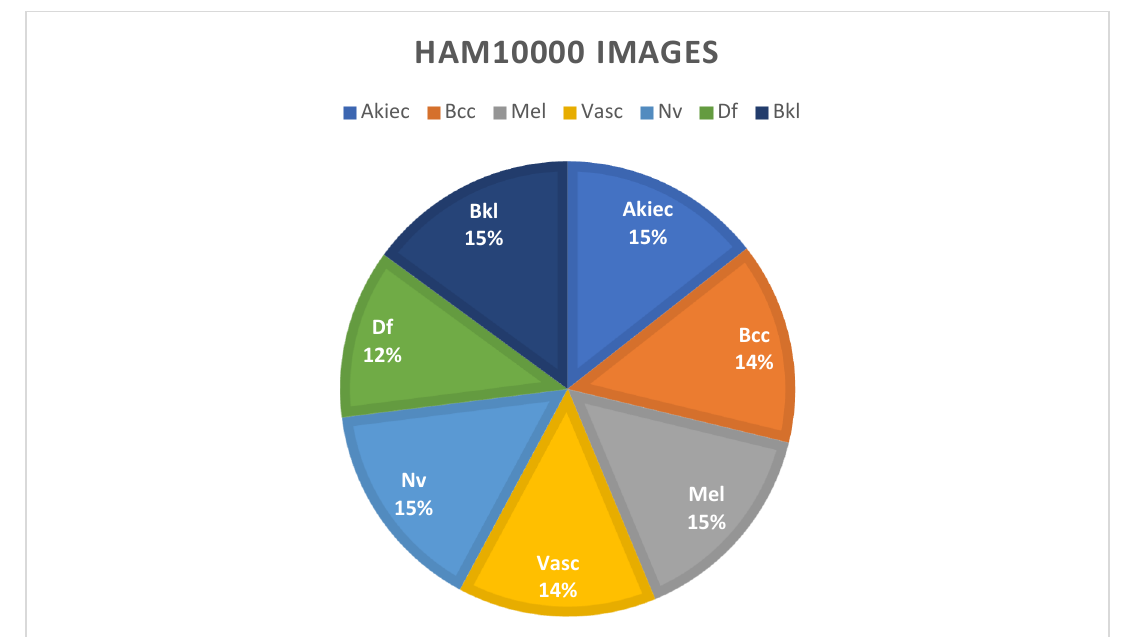
Figure 7. Unbalanced dataset before applying augmentation techniques.